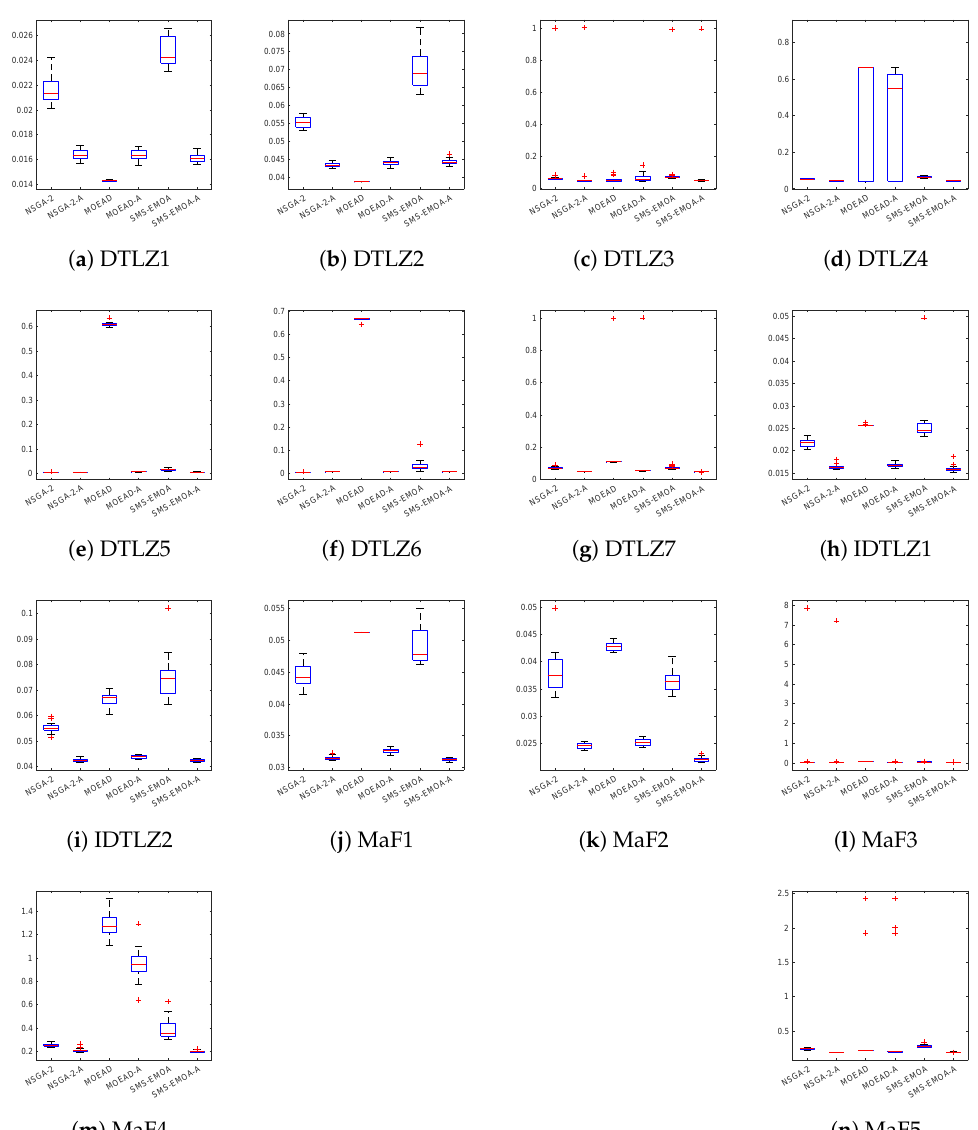
Figure A4. Boxplots for the considered three-objective test